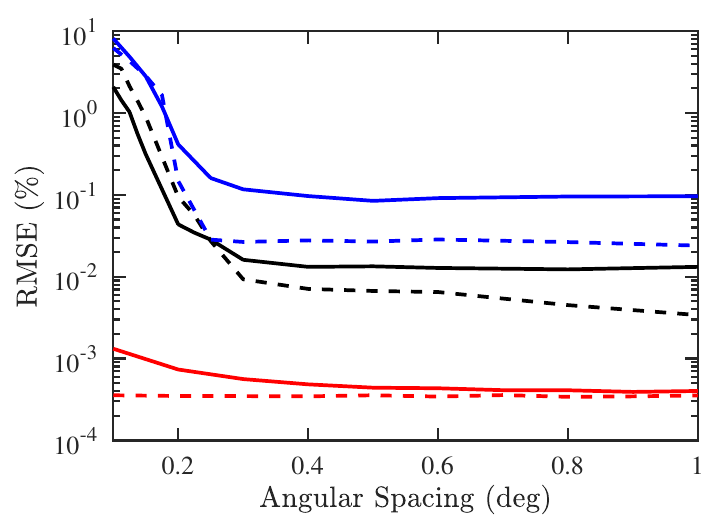
Figure 14. RMSE of DOA and CF estimation versus angular spacing, SNR = 10 dB, Q = 300, M =